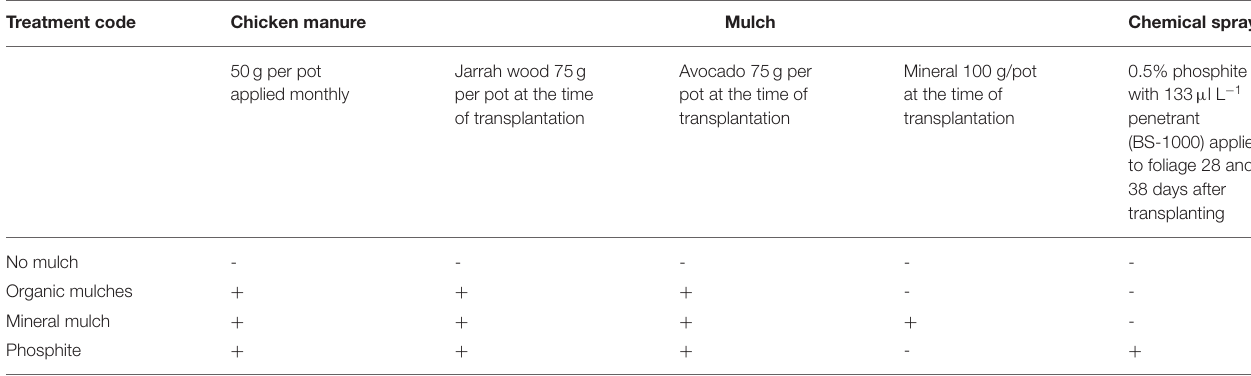
TABLE 1 | Experimental treatments. Treatment